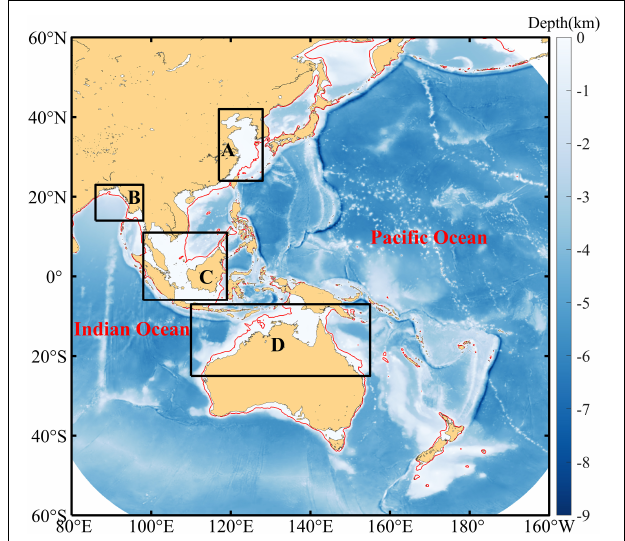
FIGURE 1 | Bathymetry in the whole observational area of Himawari-8. Red lines represent the isobath at 100 m and the Chl- a variations within the four regions in the black boxes (namely, A, B, C, and D) are discussed